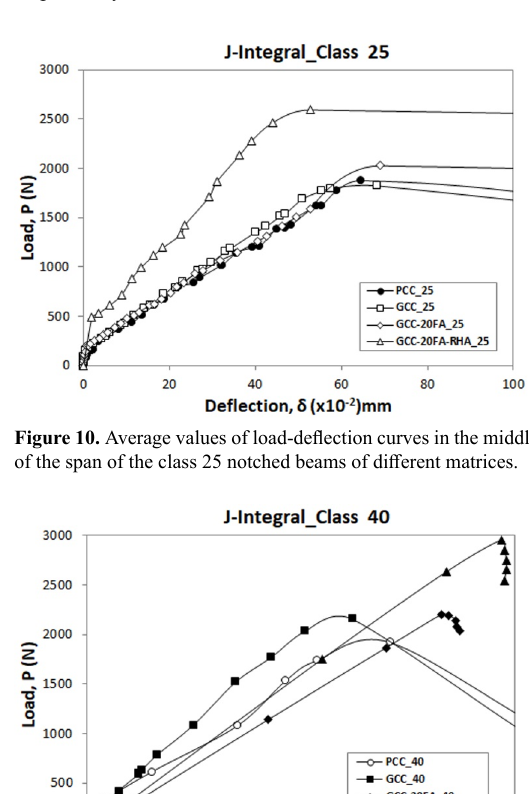
Except for PCC notched beams, all the others presented increase of P with the increase of strength class, especially max the GCC-20FA-RHA.